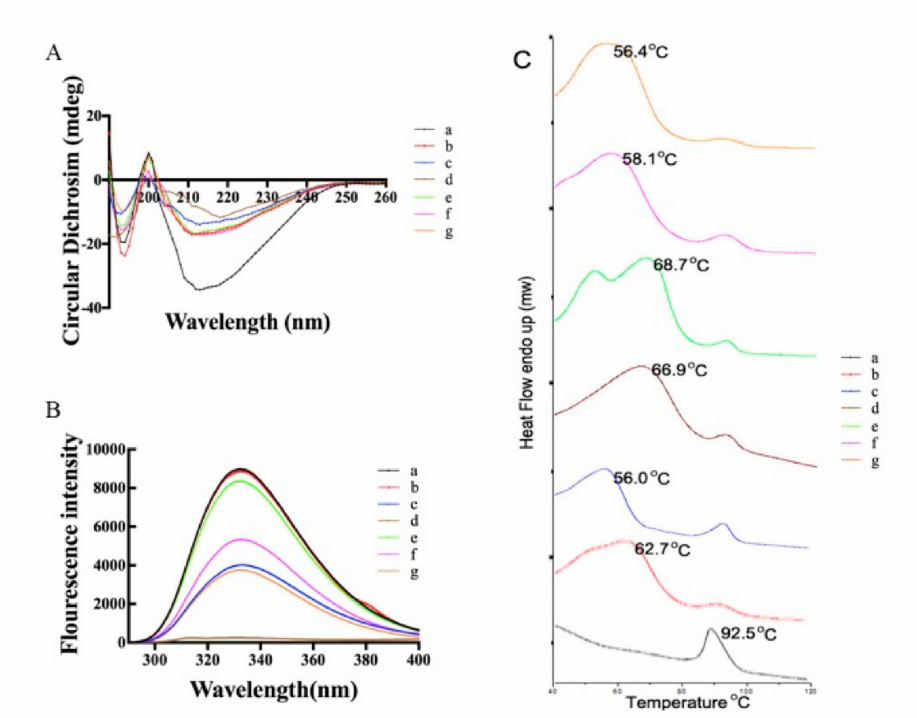
Figure 2. Effect of AAPH-CA and acrolein-CA on: ( A ) CD spectroscopy, ( B ) intrinsic fluorescence absorption, and ( C ) DSC thermograms. Figure ( C ) a–g represents: ( a ) control (native CA); ( b ) 1 mmol/L AAPH; ( c ) 5 mmol/L AAPH; ( d ) 25 mmol/L AAPH; ( e ) 0.1 mmol/L acrolein; ( f ) 1 mmol/L acrolein; and ( g ) 10 mmol/L